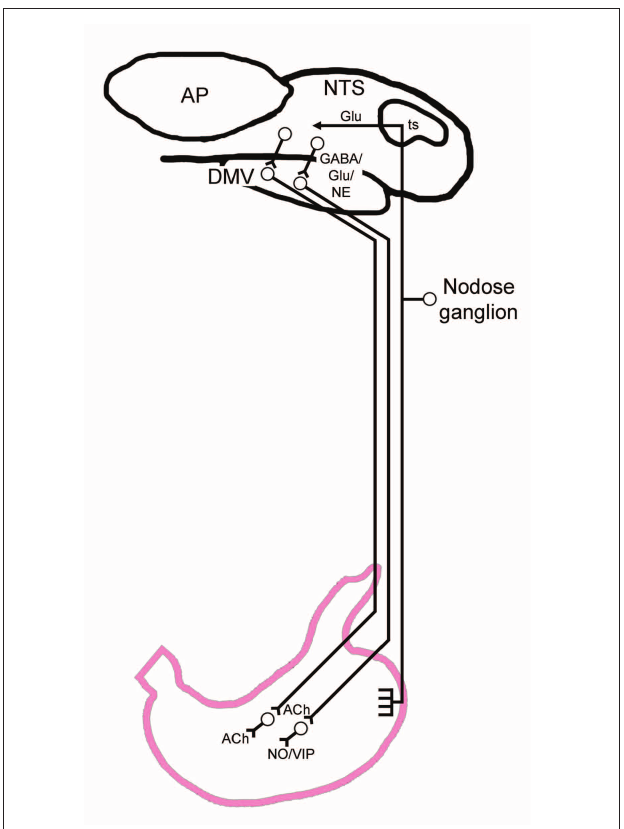
FIGURE 1 | General visceral afferent signals are transmitted to the brainstem by afferent fibers distributed throughout the proximal GI tract that traverse within the vagus nerve. The dashed line arbitrarily indicates the transition between the fundus (orally) and the corpus (caudally). The cell bodies for these vagal afferents reside within the nodose ganglion. Vagal afferents enter the brainstem by way of the tractus solitarius (ts) and terminate principally as a glutamatergic (Glu) synapse onto second order neurons within the nucleus tractus solitarius (NTS). At the level of the NTS, converging projections from higher CNS centers (not pictured) are integrated and relayed by NTS neurons to regions which include the parasympathetic preganglionic neurons of the dorsal motor nucleus of the vagus (DMV) using the neurotransmitters GABA, glutamate or norepinephrine (NE). Together with the area postrema (AP) the NTS and DMV form the region of the dorsal vagal complex. Preganglionic DMV motor neurons innervate gastric enteric neurons by way of two competing pathways. Activation of one pathway initiates the cholinergic (Ach) mediated excitation of gastric smooth muscle which is necessary for gastric tone and motility. Alternatively, activation of a non-adrenergic, non-cholinergic (NANC) pathway exerts a profound gastric relaxation through the release of nitric oxide (NO) or vasoactive intestinal polypeptide (VIP). Reduction in gastric tone and motility, therefore, can be produced by either the withdrawal of excitatory cholinergic drive, or activation of NANC-mediated